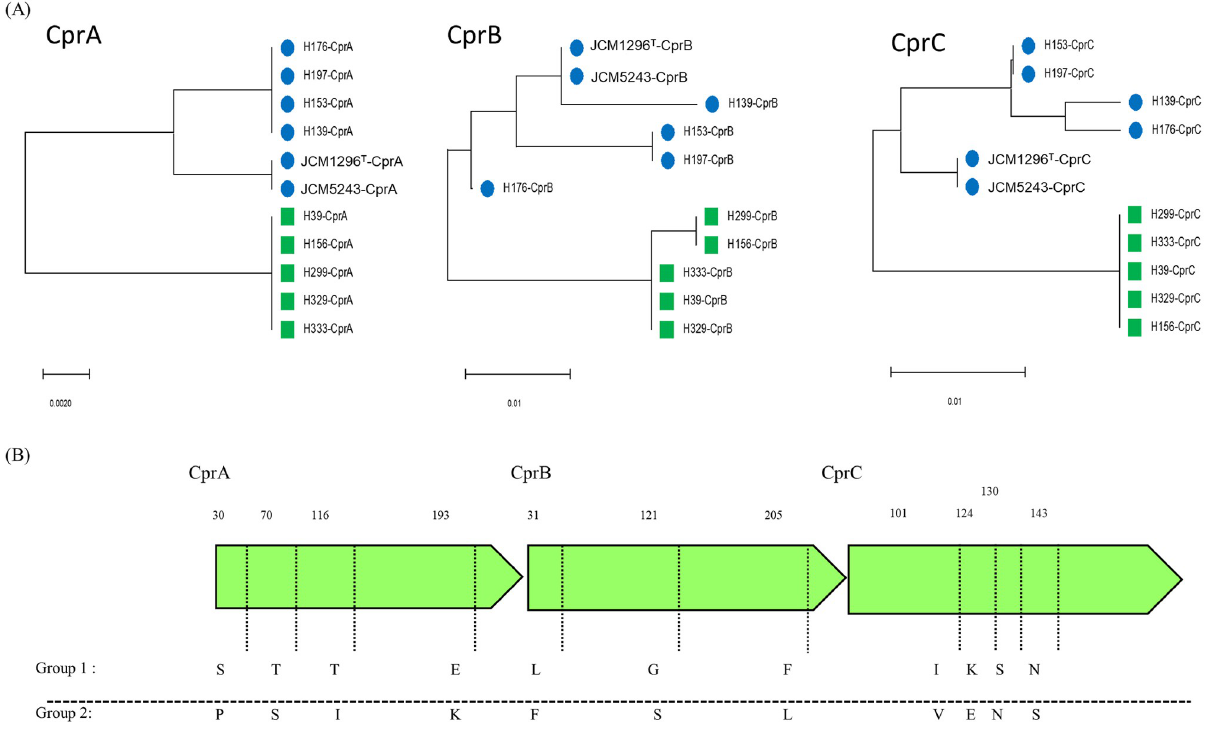
Fig 7. Comparison of CprABC amino acid sequences among 11 C . difficile strains. (A) Phylogenetic analysis of CprA, B and C among 11 C . difficile strains including Group 1 (circle) and Group 2 (square). (B) Conserved amino acid differences between Groups 1 and Group 2.